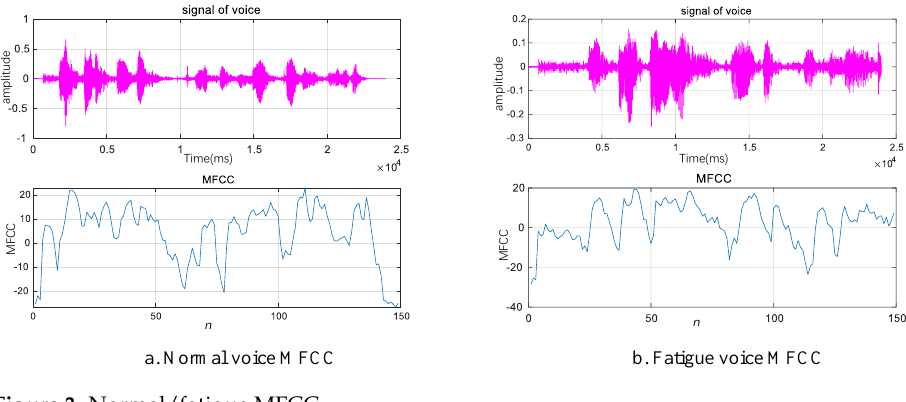
Figure 3. Normal/fatigue MFCC.